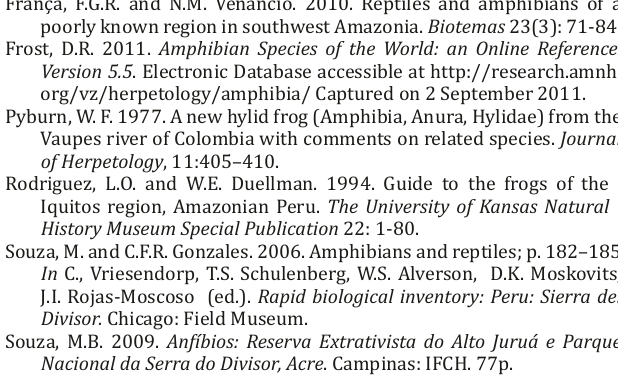
Hypsiboas microderma throughout western Amazonia. COLOMBIA: Type-locality (star): rio Vaupés, (Pyburn 1977); PERU: 1- Mazán, Loreto (Rodriguez and Duellman 1994), 2- Divisor, Loreto (Souza and Gonzales 2006). BRAZIL: 3- Parque Nacional da Serra do Divisor, Mâncio Lima, Acre (Souza 2009), 4- Cruzeiro do Sul, Acre (Cardoso and Vielliard 1990), 5- Boca do Acre, Amazonas (França and Venâncio 2010), 6- Fazenda Experimental Catuaba, Senador Guiomard, Acre (this study) and 7- Estação Ecológica do Cuniã, Porto Velho, Rondônia, (this